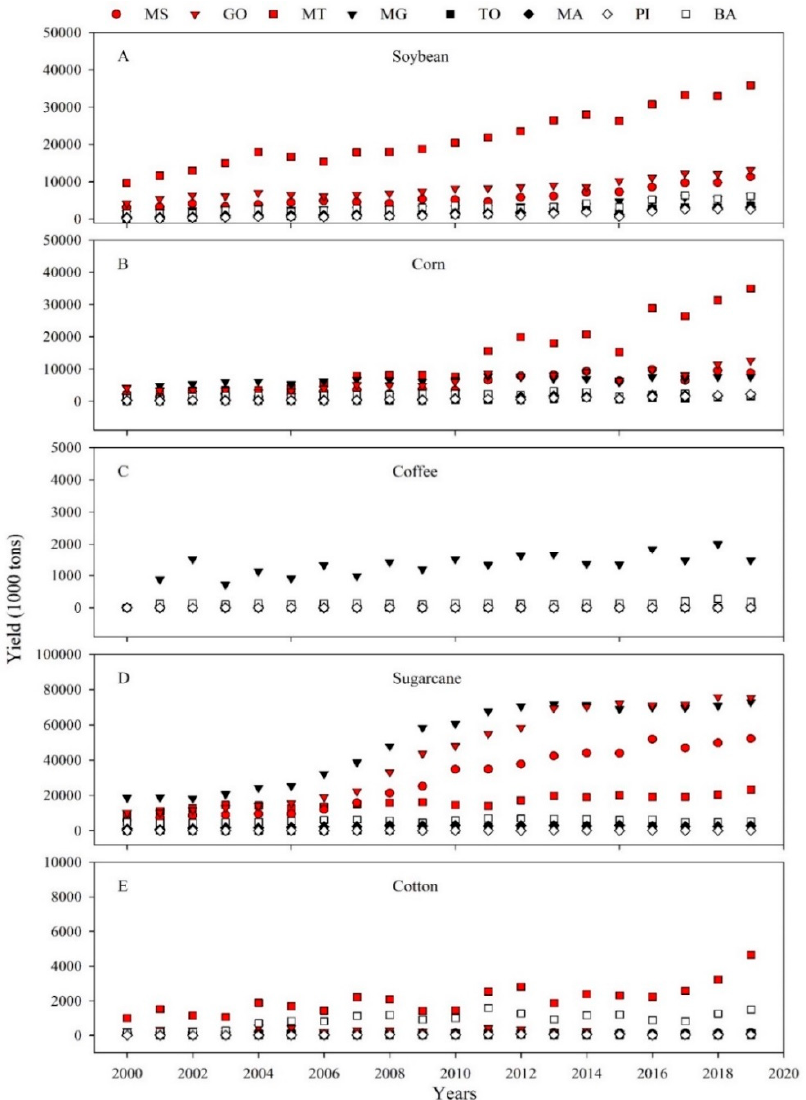
Figure 6. Annual crop yield of the Cerrado (1000 tons) in Minas Gerais (MG), Goiás (GO), Mato Grosso (MT), Tocantins (TO), Maranhão (MA), Bahia (BA), Mato Grosso do Sul (MS), and Piauí (PI) of soybean, corn, coffee, sugarcane, and cotton from 2000 to 2020.